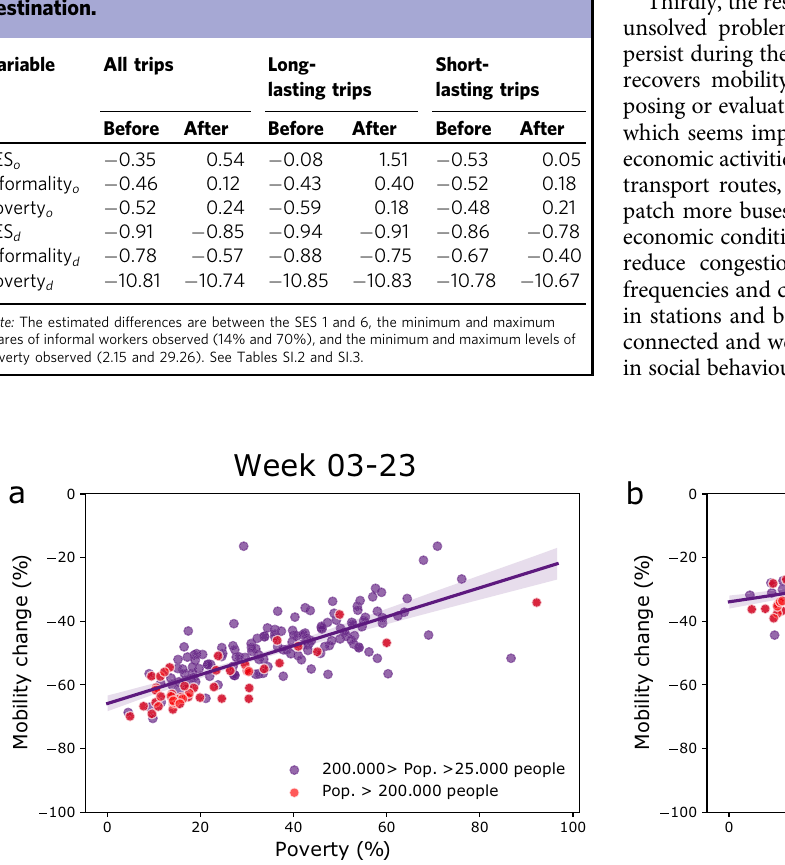
Fig. 4 Mobility changes vs. poverty across the country. We explore the relationship between the variation in mobility and poverty levels at a municipality level for ( a ) national lockdown week and ( b ) the selected week of partial lockdown. We distinguish large urban areas with more than 200,000 inhabitants (red) from medium-size towns with more than 25,000 inhabitants (purple). The correlation is good in both cases, and it seems not to depend on the city ’ s size. In the case of partial lockdown conditions, the high dispersion of points can be due to the different lockdown strategies imposed by the local